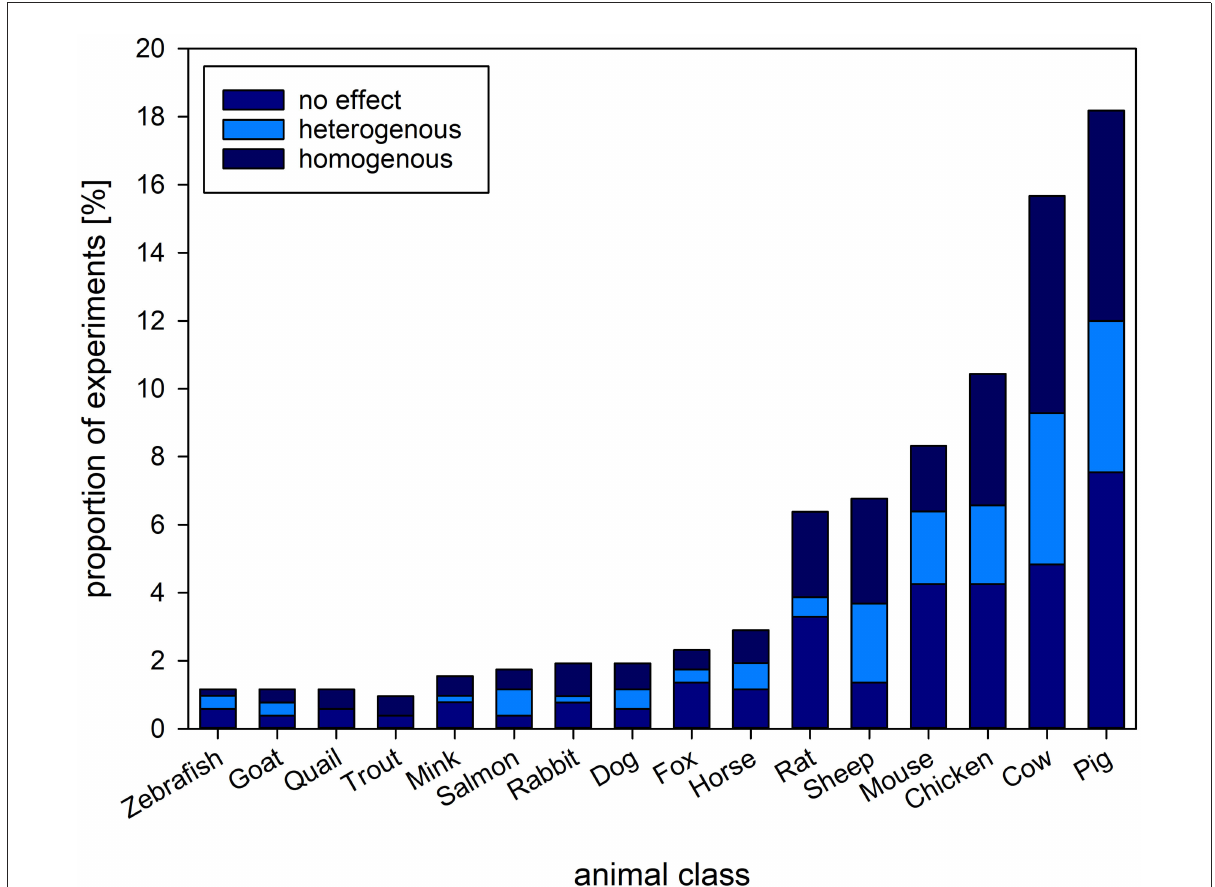
FIGURE5 Proportion [%] of experiments and the types of animals investigated. Stacked bars refer to the proportion of experiments reporting on homogenous (consistent change in readout parameter compared to baseline/control), heterogenous (inconsistent change in readout parameter compared to baseline/control) or no effect of an intervention on GC levels found among the species investigated. The figure shows the types of animals with a proportion above 1% of the complete set of